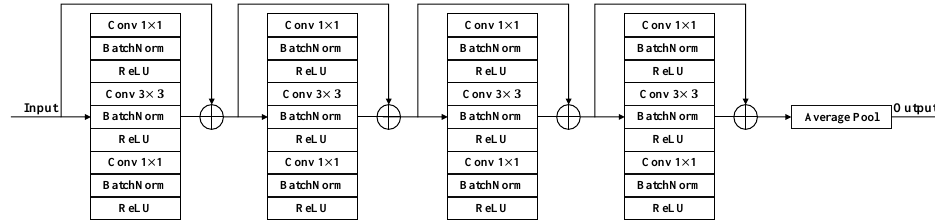
Figure 2. The structure of the backbone.